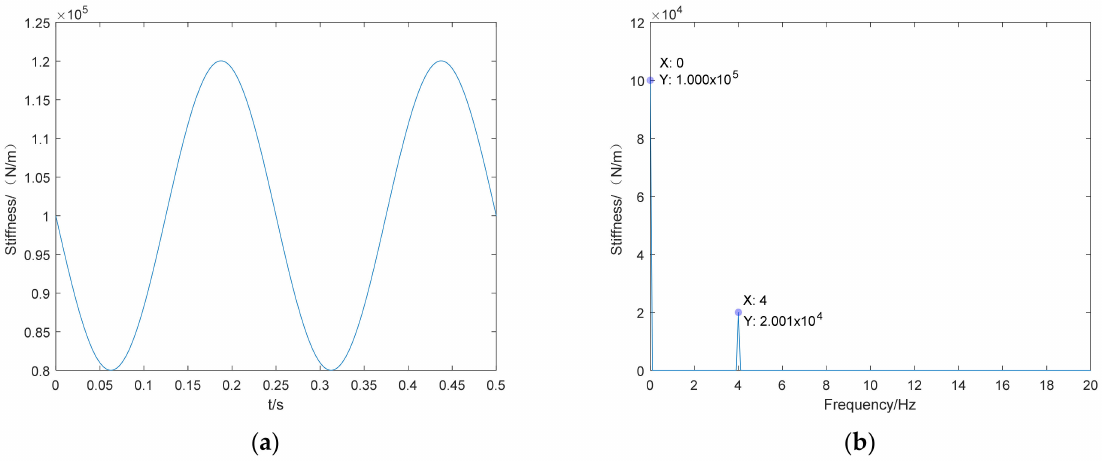
Figure 7. Time domain identification result ( a ) and frequency domain identification results ( b ) of time-varying stiffness k ∗ . 3